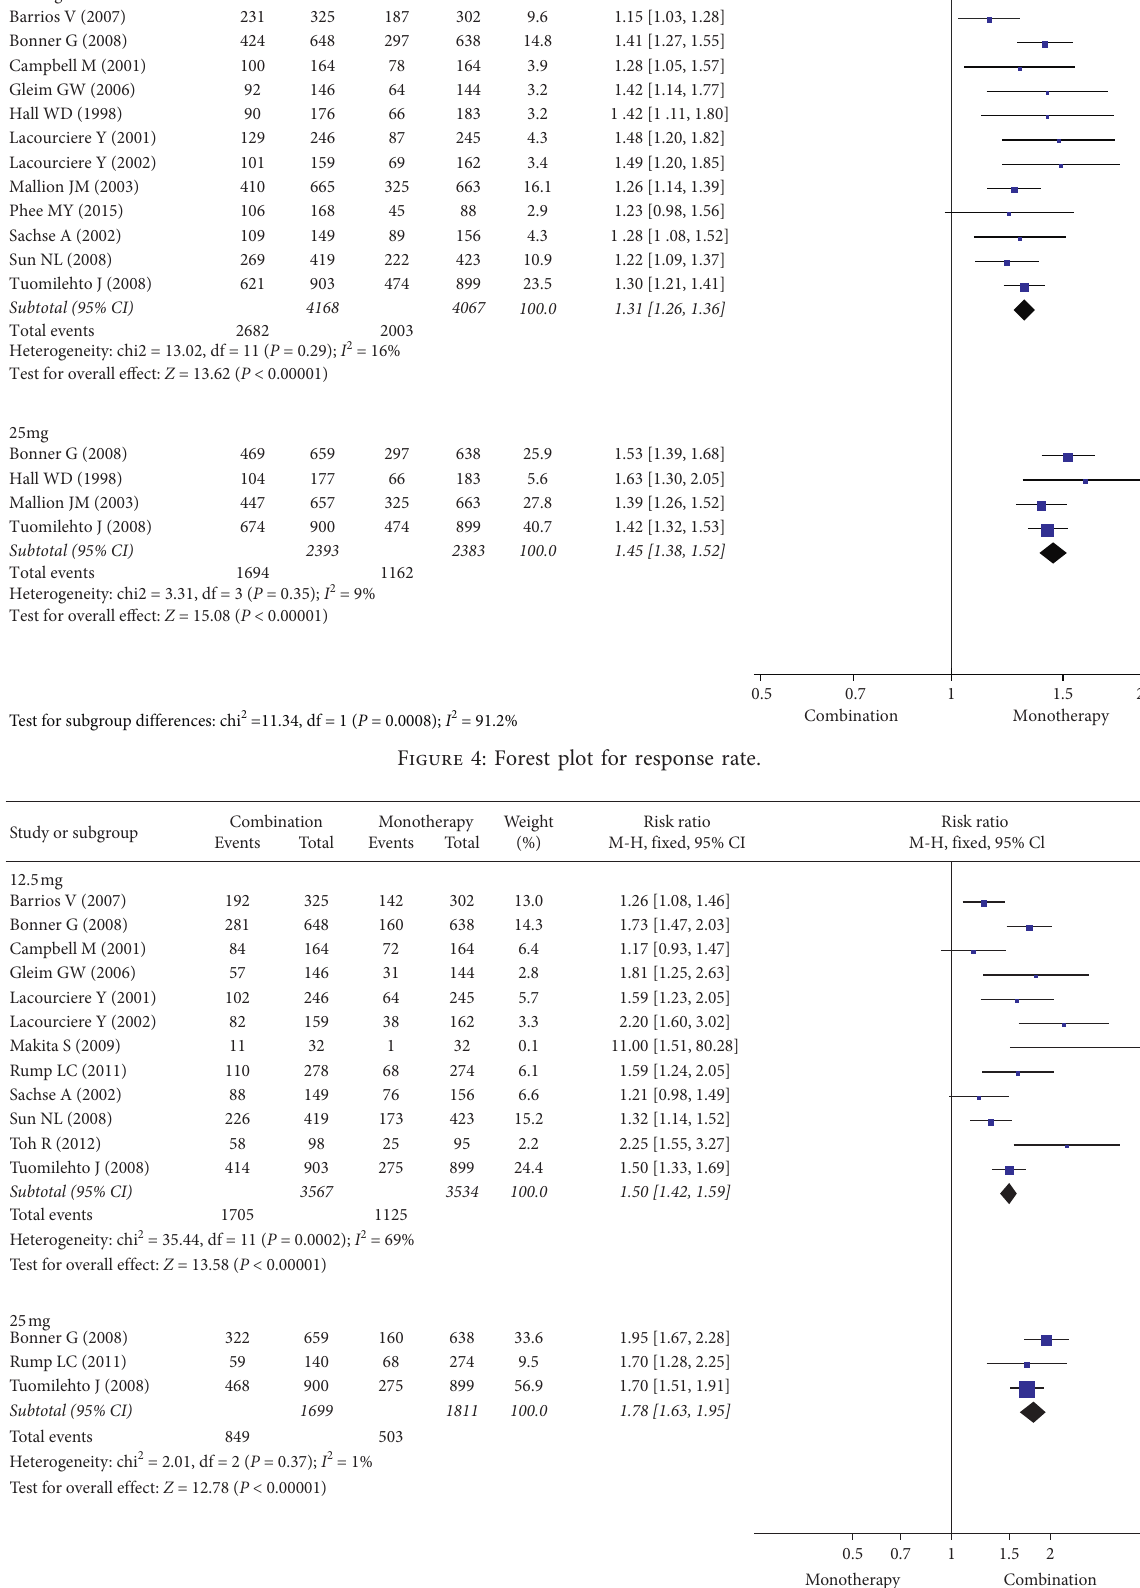
Figure 5: Forest plot for BP goal achievement